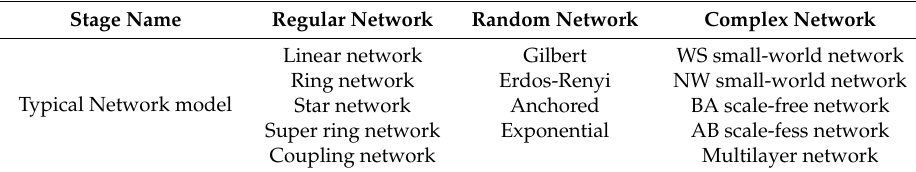
Table 1. Typical network